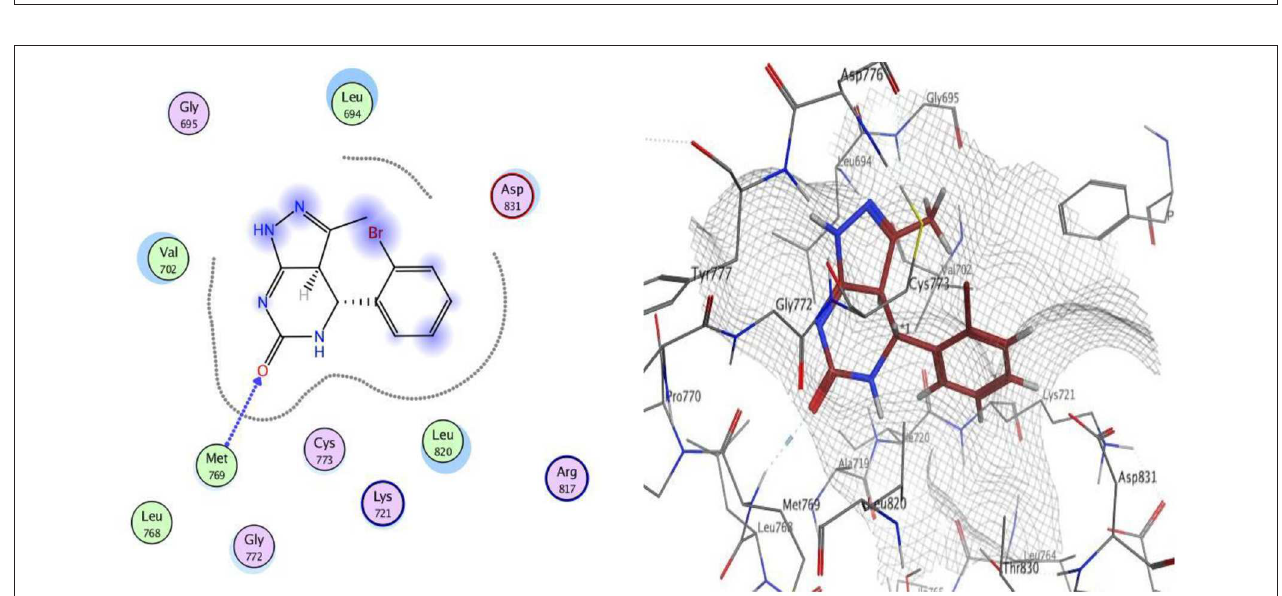
FIGURE 2 | 2D and 3D interaction map of compound 9 within the active site of EGFR (3POZ).